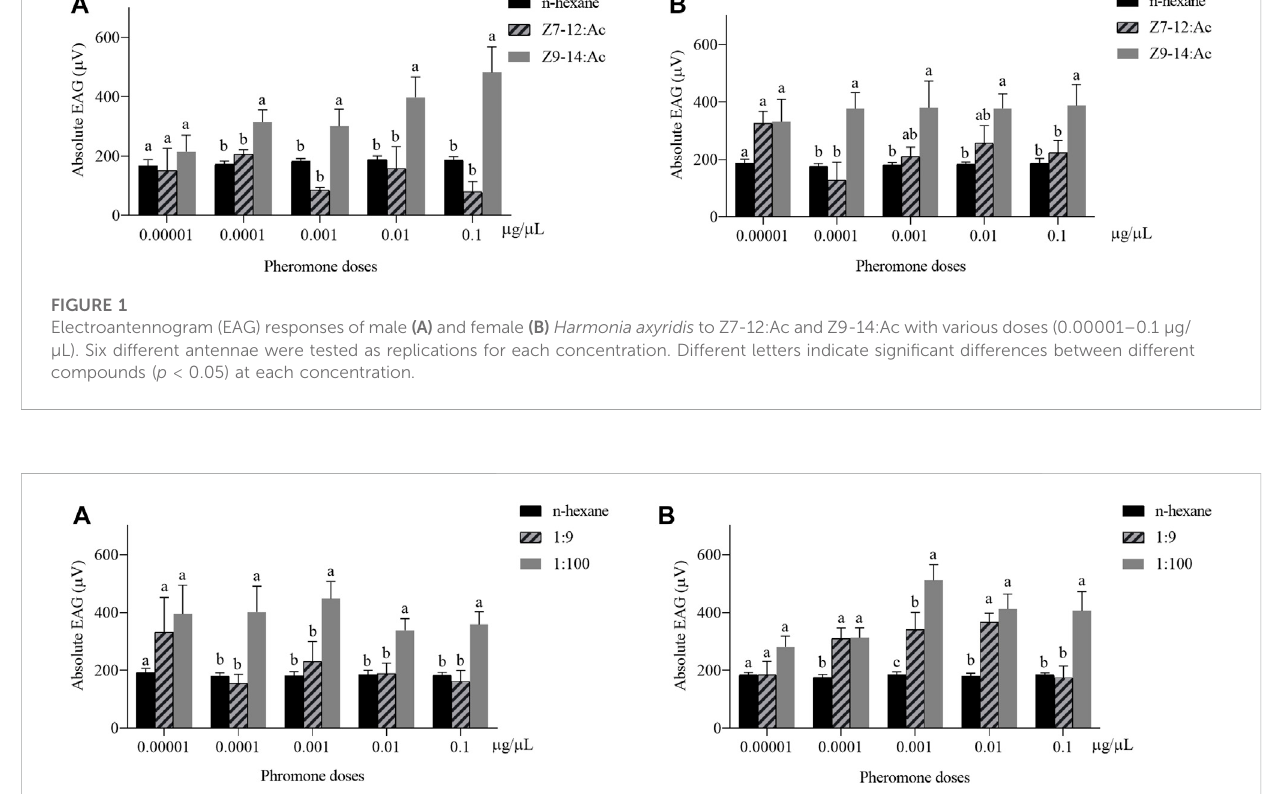
FIGURE 2 Electroantennogram (EAG) responses of male (A) and female (B) Harmonia axyridis to the blend of Z7-12:Ac and Z9-14:Ac at the ratios of 1:100 and 1:9. Six different antennae were tested as replications for each concentration. Different letters indicate signi fi cant differences at each concentration ( p <